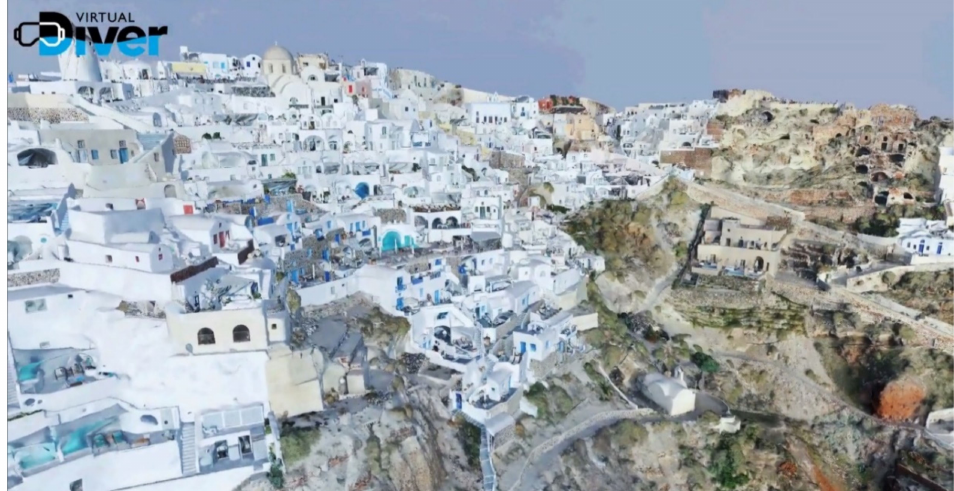
Figure 19. 3D environment of City of Oia. (3D Model has been produced by Up2metric VIRTUALDriver partners)